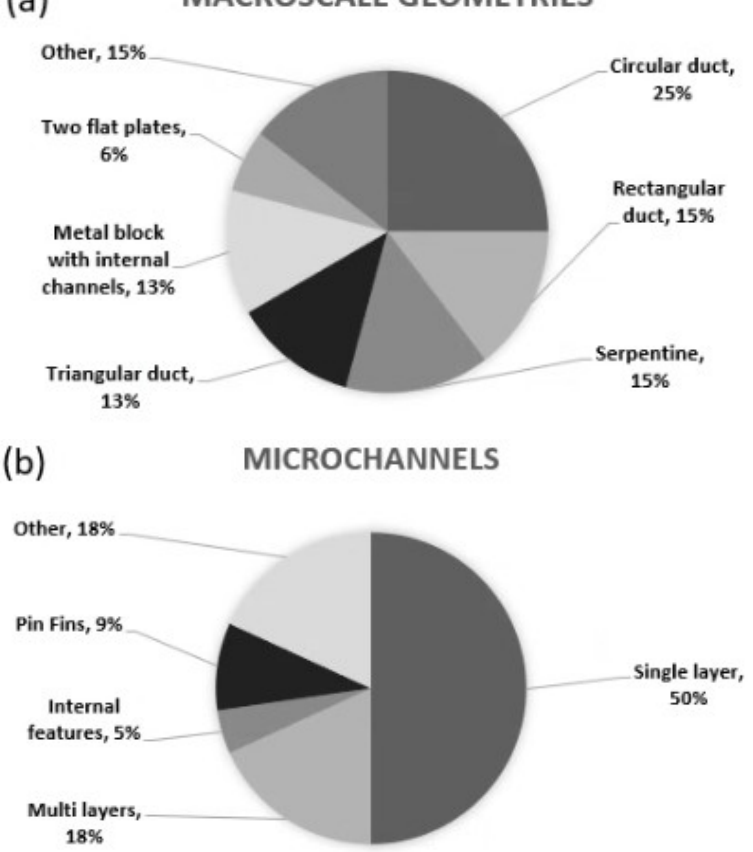
Figure 38. Pie chart showing the share of individual geometry designs regarding heat extraction devices with ( a ) macroscale channels and ( b ) microscale channels.